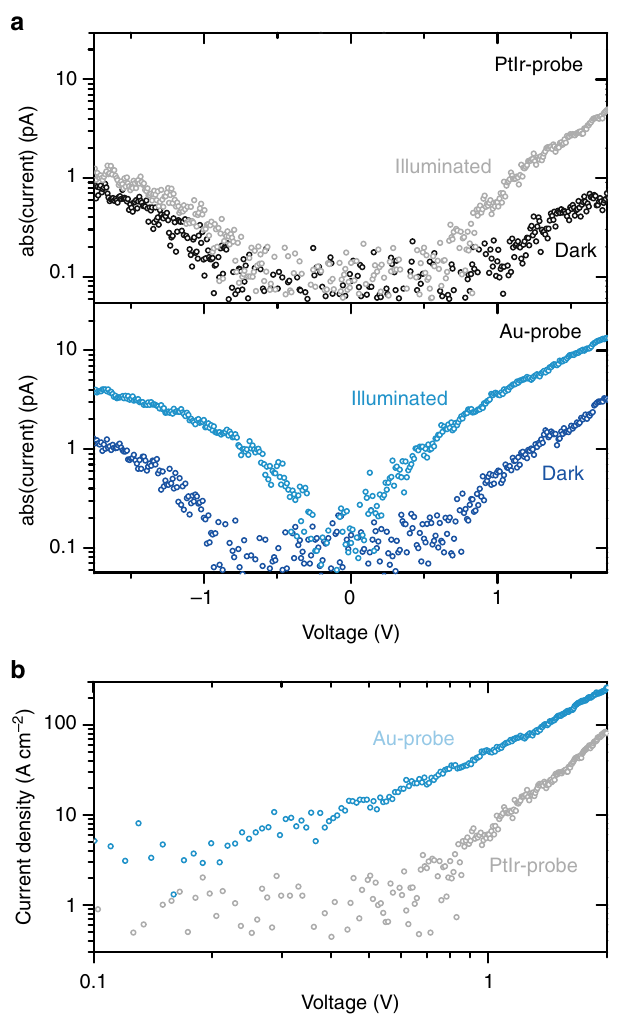
Fig. 3 Dark and photocurrent characteristics. a IV -characteristic of the FTO/BiVO 4 /probe circuit under illumination and in dark for PtIr-coated and Au-coated probes at the same sample position. b Current density under illumination for PtIr-coated and Au-coated probe calculated using the corresponding contact area between probe and BiVO 4 . We used the Derjaguin – Mueller – Toporov continuum mechanical model to estimate the contact area between the surface and the probe 34 . All IV -curves show strong nonlinear behavior, thereby excluding ohmic contact and wiring resistance as limiting factors in overall electronic transport through the photoanode